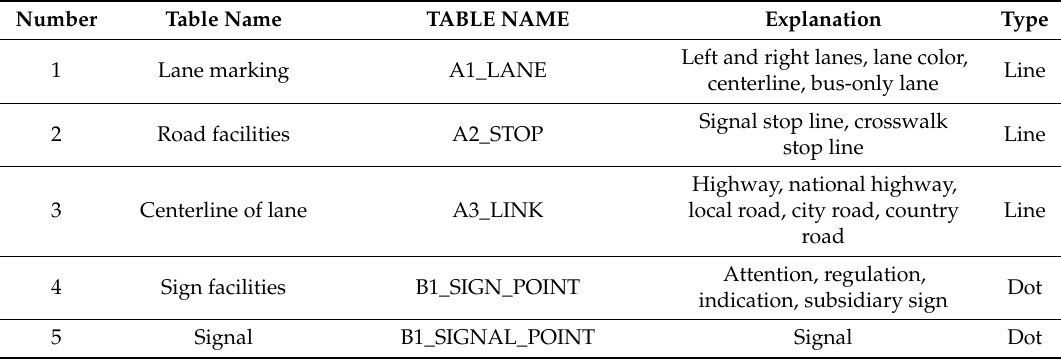
Table 1. Specific items used in building a high-precision road map.